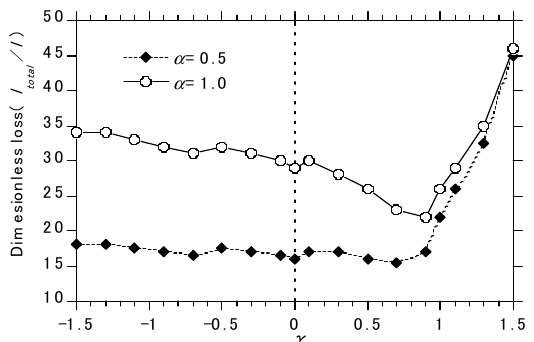
Figure 9. Difference in dimensionless loss due to difference in 𝛾 .